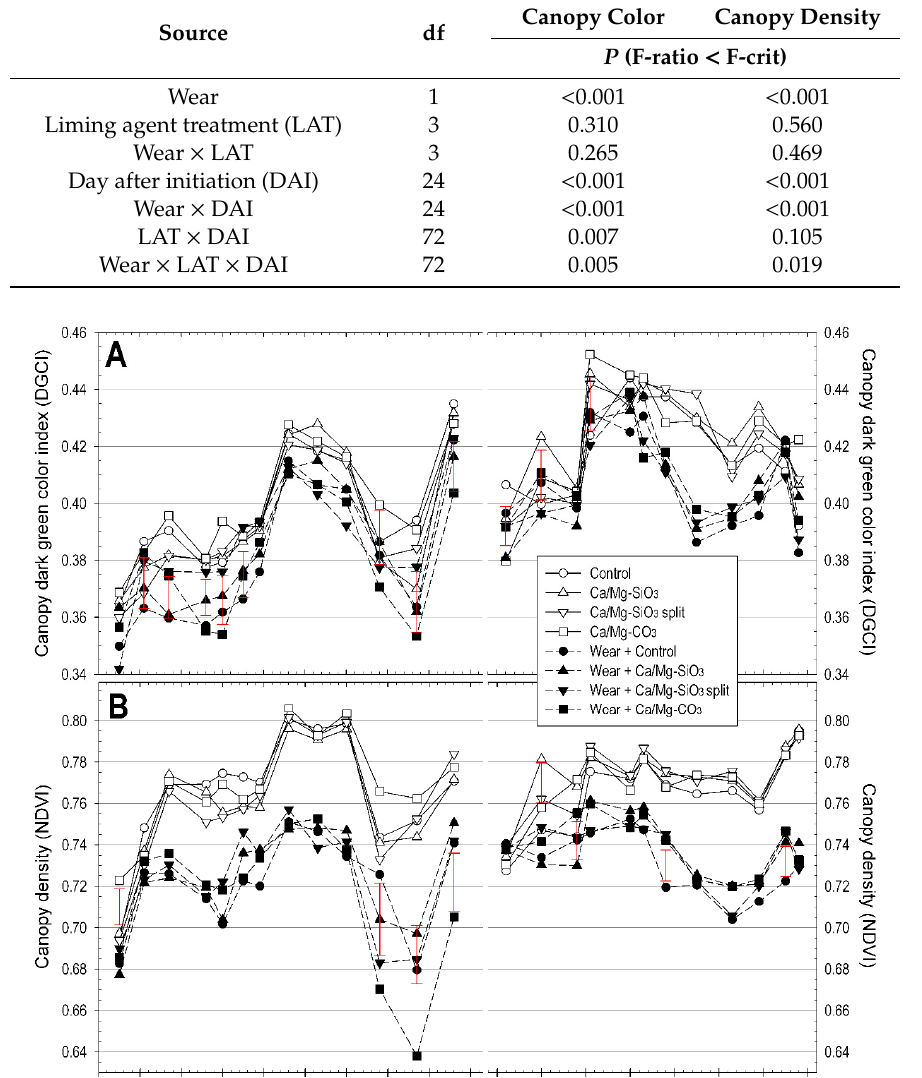
Table 4. ANOVA of creeping bentgrass canopy dark green color index (DGCI) and density (normalized differential vegetative index, NDVI) by source.